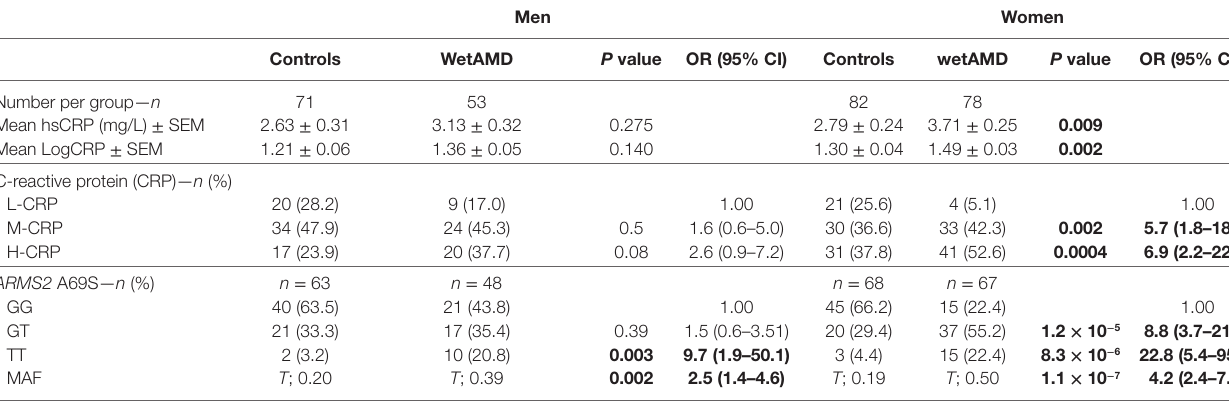
Table 3 | Subgroup analysis by gender. Men Women controls WetaMD P value Or (95% ci) controls wetaMD P value Or (95% ci)